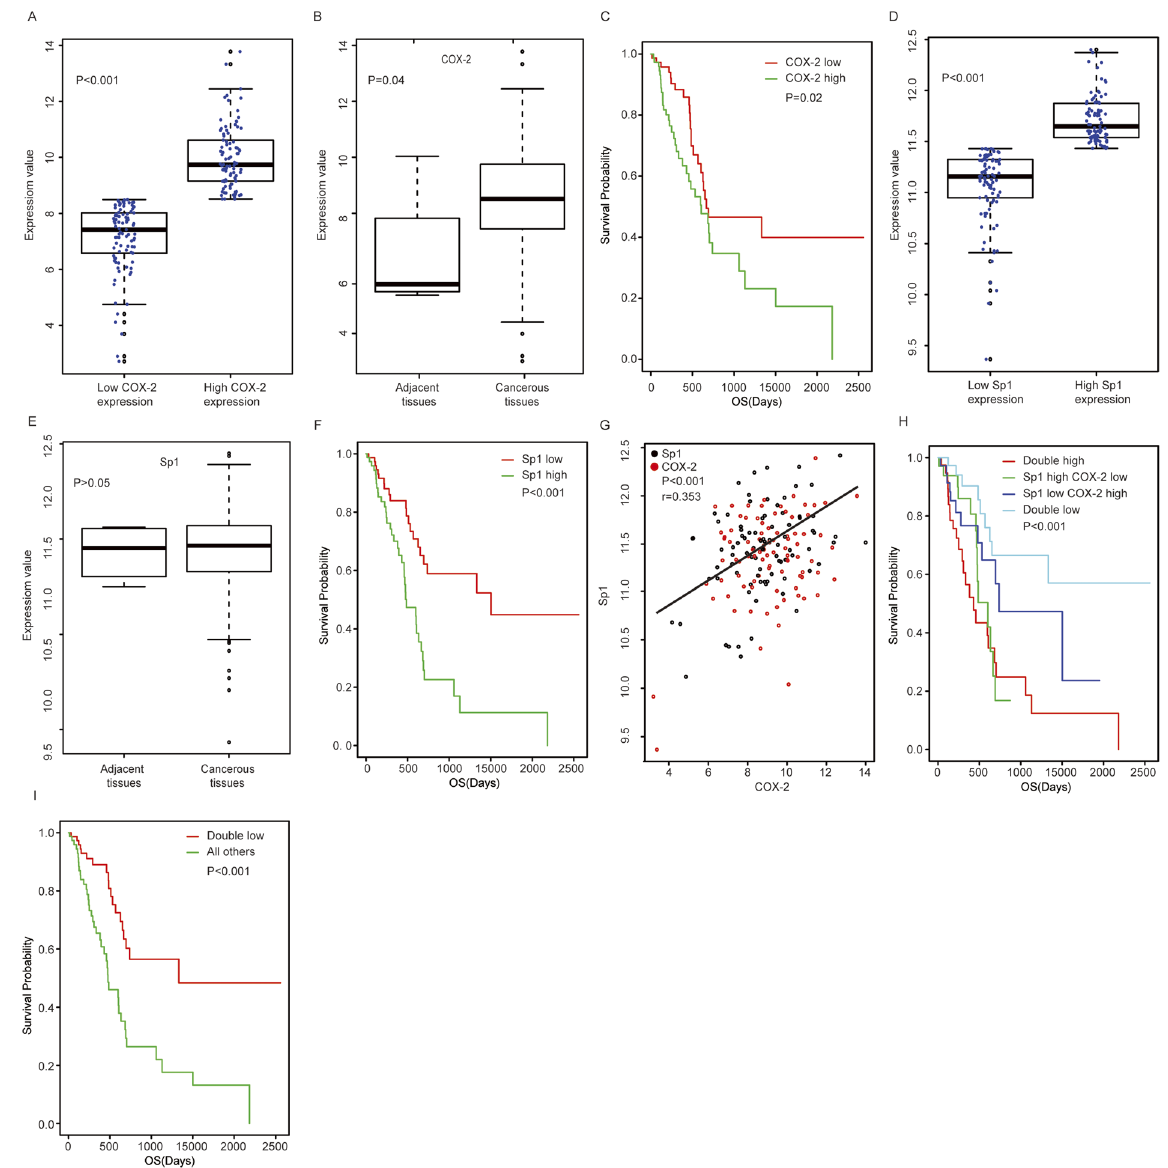
Figure 1. Correlated COX-2 and Sp1 expression in PDAC tissues. ( A ) The comparison of COX-2 expression between the high expression group and the low expression group. ( B ) The comparison of COX-2 expression between the cancerous tissues and the paired non-cancerous tissues. ( C ) Survival analysis based on COX-2 expression. ( D ) The comparison of Sp1 expression between the high expression group and the low expression group. ( E ) The comparison of Sp1 expression between the cancerous tissues and the paired non-cancerous tissues. ( F ) Survival analysis based on Sp1 expression. ( G ) Correlation analysis between COX-2 and Sp1. ( H,I ) Survival analysis based on Sp1 and COX-2.